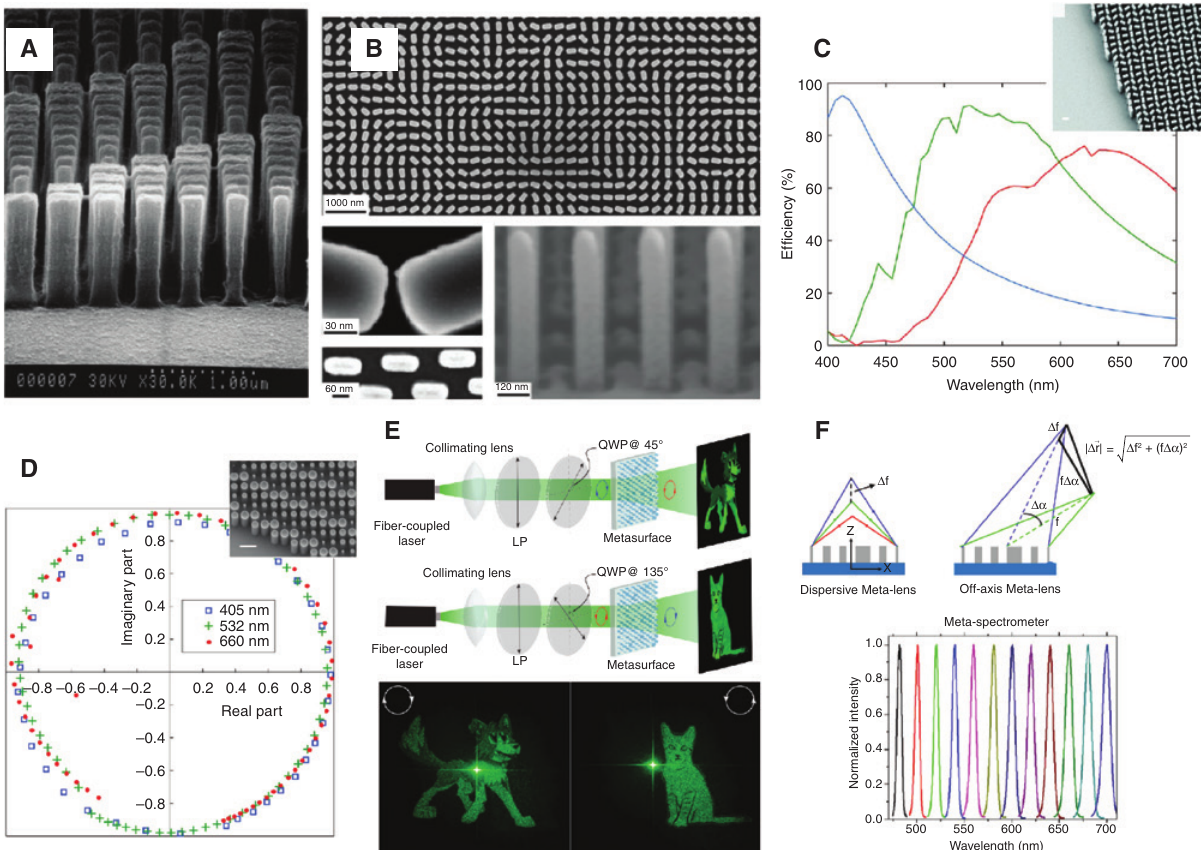
) as a metasurface material platform. Figure 5: Titanium dioxide (TiO 2 (A) Scanning electron micrograph (SEM) of a blazed binary diffractive lens made of top-down etched TiO nanopillars; the local effective 2 refractive index is controlled by the width of the pillars. (B) SEM of TiO metalens fabricated using the bottom-up atomic layer deposition 2 (ALD) method. Inset: Cross-section view of the nanofins exhibiting vertical sidewalls with a height of ~ 600 nm. (C) Simulated focusing efficiency of three metalenses designed for wavelengths 405 (blue curve), 532 (green curve), and 660 (red curve) nm and SEM of fabricated metalens. Inset: measured focal spot intensity at designed wavelength 405 nm (NA = 0.8). (D) Simulated complex transmission coefficients of cylindrical nanopillars with various diameters at three design wavelengths: 405, 532, 660 nm. Each point represents the amplitude and phase of the transmission of a nanopillar, and the entire 2 π phase coverage is realized by varying the nanopillar diameter. (E) Top: different holograms are imaged with LCP and RCP light illuminating on the same TiO metasurface, which decouples the propagation phase design 2 and geometric (Pancharatnam-Berry) phase design by controlling the nanofin dimensions and rotation angles, respectively. Bottom: images formed with RCP and LCP light, respectively. (F) Left: schematic of the off-axis meta-lens that focuses light of different wavelengths to differ- ent angles. Right: measured spectra from a supercontinuum laser with a planar ultracompact visible chiral spectrometer designed based on the off-axis focusing lens; the performance is comparable to a commercial handheld spectrometer. (A) reprinted with permission from [103], copyright 1999 by The Optical Society; (B) reprinted with permission from [154], the authors; (C) reprinted with permission from [27], copy- right by the American Association for the Advancement of Science; (D) reprinted with permission from [110], copyright 2016 by the American Chemical Society; (E) reprinted with permission from [155], copyright 2017 by American Physical Society; (F) reprinted with permission from [156], using the Creative Commons Attribution (CC BY)